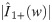
Validation of Eq (72) along the real axis w, by substituting η = −k cos w.Left: absolute value of |I^1+(w)| (exact = thick solid gray line, approximate = solid black line). Right: relative error in log10 scale obtained from the approximate expression of I1+(η) for η = −k cos w given by Eq (72) while substituting the exact expression of V1+(η) and performing the numerical integration. Test cases are relative to different sets of parameters: Φa,=0.7π,0.4π,0.18¯π, Φb = 1.2π, φo = 0.1π. We recall that −π < w < 0 is the portion of real axis of w plane in the proper sheet of η plane.